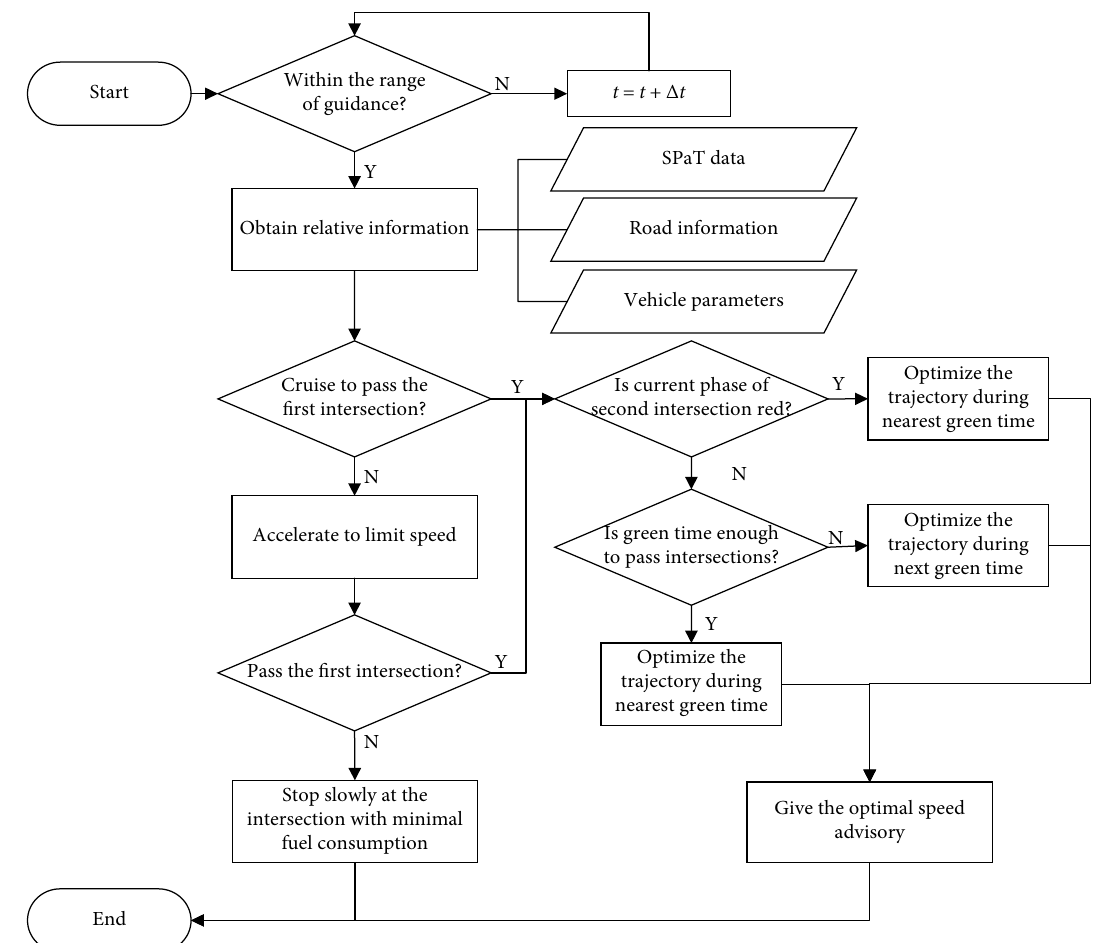
Figure 3: Optimization logic of the